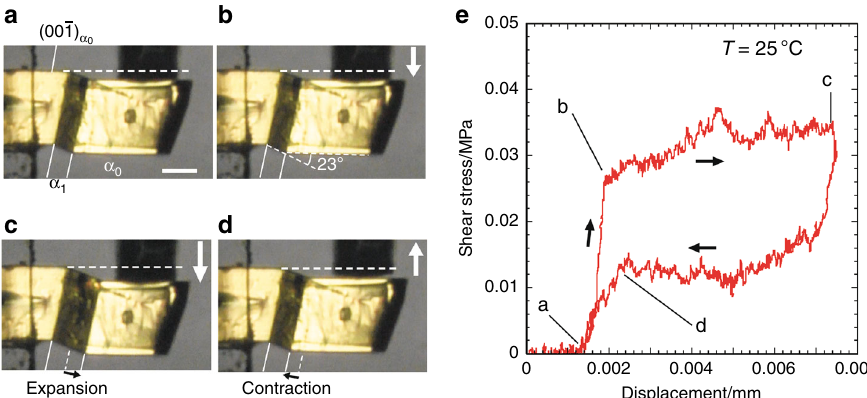
Fig. 3 Shear test of a crystal of 1 : superelasticity. a – d Snapshots of a crystal of 1 during deformation. Scale bar, 100 μ m. e Stress – strain curve at room temperature. a – d in e represent the same states of the crystal presented in a –